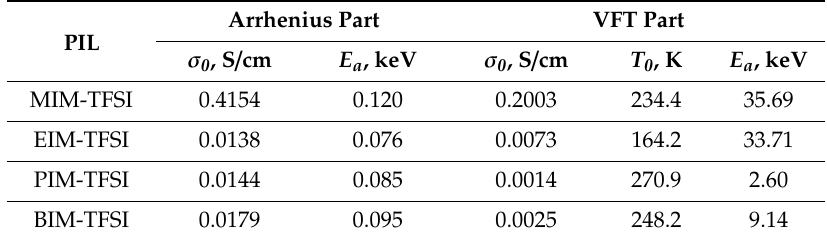
Table 2. Fitted values of the ionic conductivity according to the Arrhenius (Equation (2)) and VFT (Equation (4)) equations. Arrhenius Part VFT Part PIL σ / cm E σ / cm T a , keV 0 , S 0 , S 0 , K E a ,